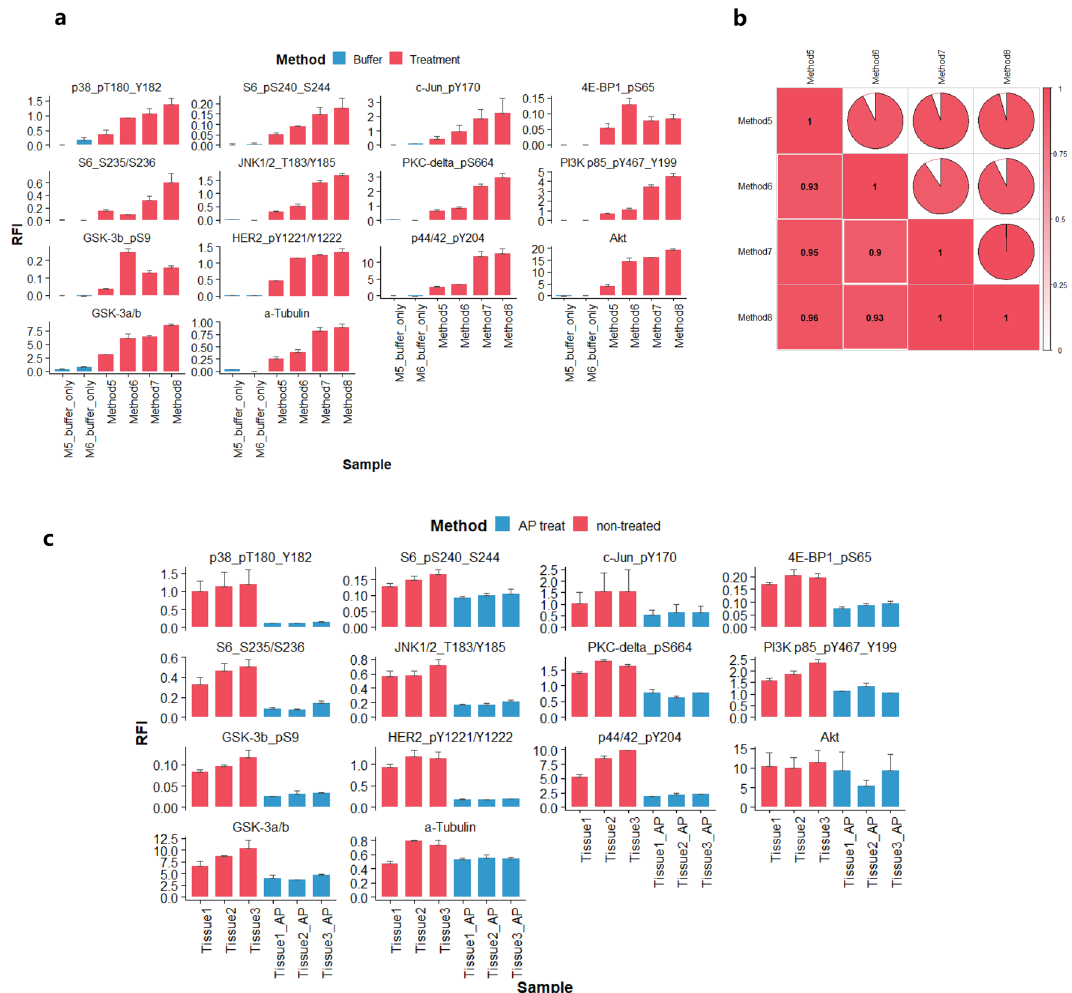
Figure 3. RPPA profiling of multiple targets using 4 extraction methods on FF samples. ( a ) Expression profiling of 3 extraction methods (method 5–8) presented by arbitrary units (relative fluorescent intensity RFI) and error bars represent standard deviation from 3 independent extractions. Blue bars are on-chip buffer only controls assessed within the same experiments. ( b ) Inter-method correlation based on 14 protein markers and R 2 are shown from white to red (0–1). ( c ) Comparison of AP-treated and non-treated FF samples using RPPA profiling on independent replicates. Non-treated controls are depicted in red and AP-treated are in blue. Each bar represents 3 individual extractions from parallel slides derived from same tissue origins. Error bars are standard deviation between 3 experimental